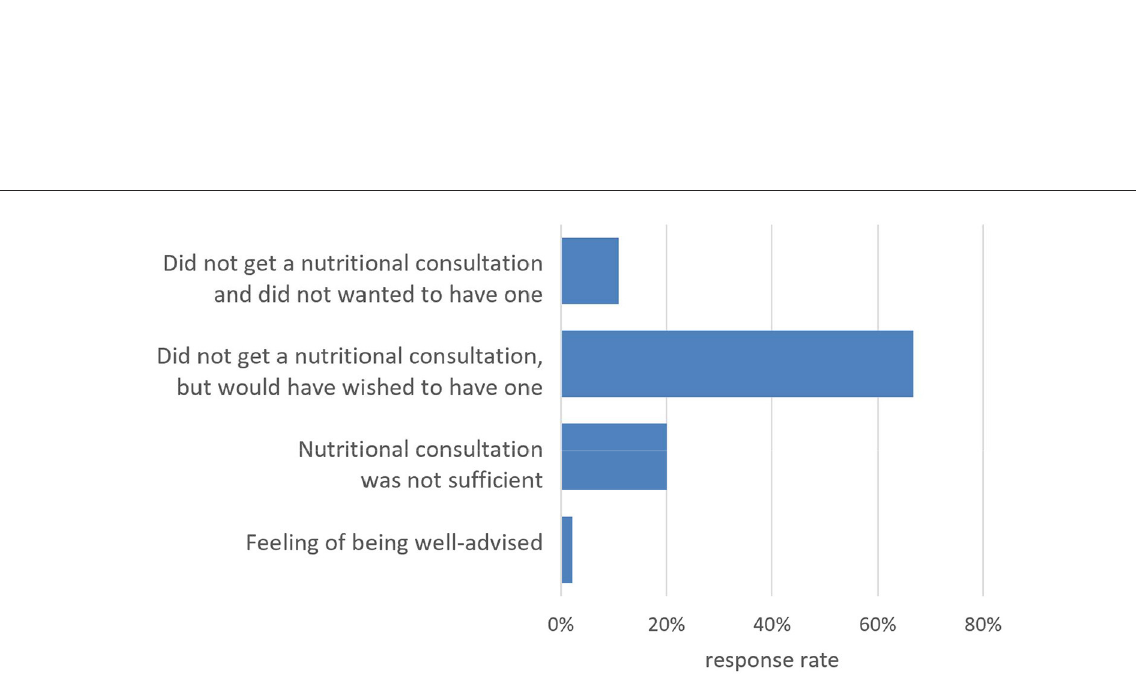
FIGURE3 Responses to the question of whether or not participants felt sufficiently advised about the connection between acne and nutrition after their